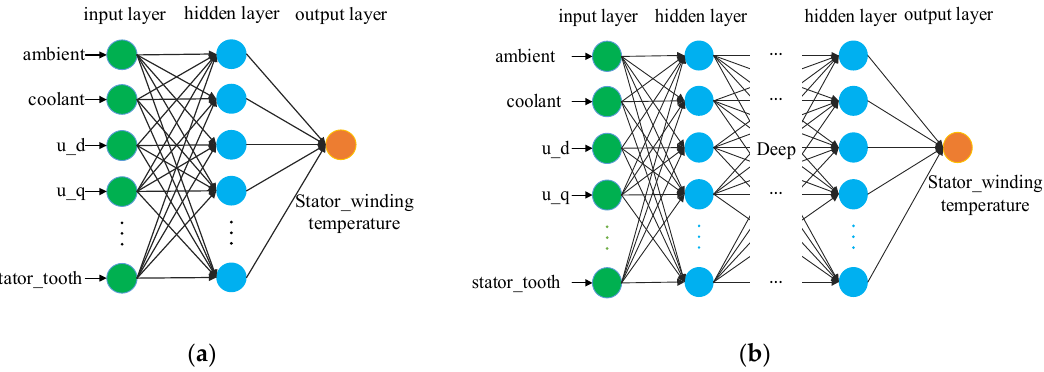
Figure 2. Structures of an artificial neural network (ANN) and a deep neural network (DNN). ( a ) A simple example of an ANN. ( b ) A DNN has two or more hidden layers.